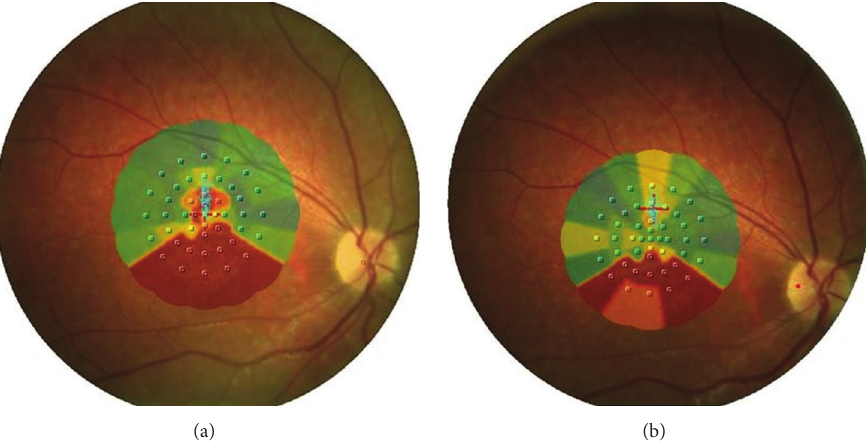
Figure 1: (a) Interpolated microperimetric map of RE before rehabilitation at zero time in which we see the image of foveal atrophy that does not allow a good fixation of the target (red cross). (b) Interpolated microperimetric map at the end of rehabilitation training after 12 months in which an improvement of fixation stability through the identification of TRL was